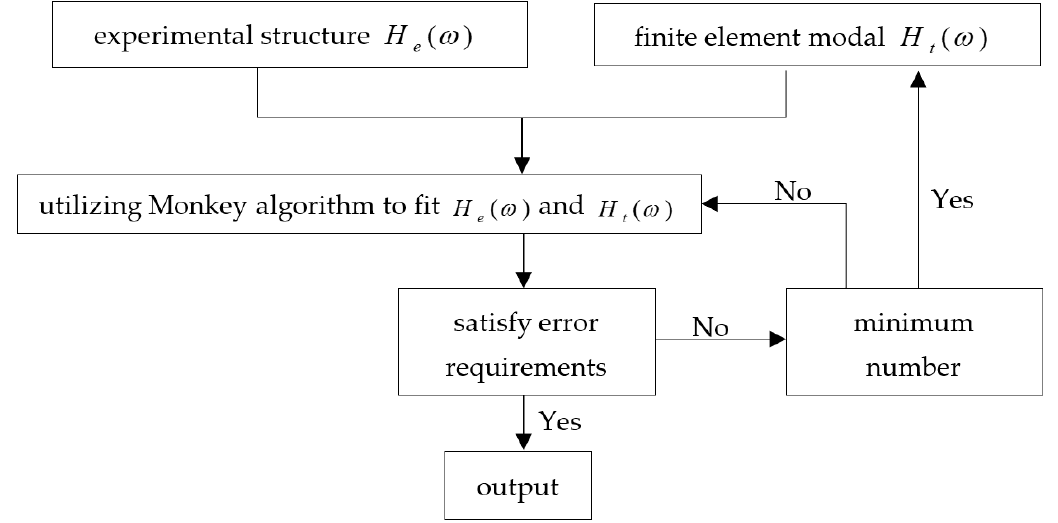
Figure 1. Process of damage identification based on frequency response function.